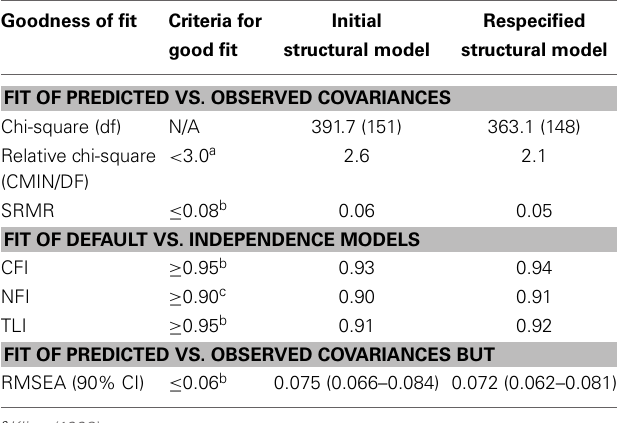
Table 5 | SEM goodness of fit statistics for the structural